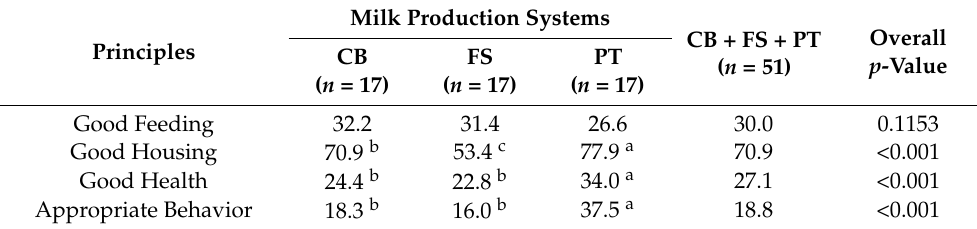
Table 2. Scores of principles of the Welfare Quality ® protocol in the compost barn (CB), free stall (FS) and pasture-based (PT) systems in Santa Catarina,